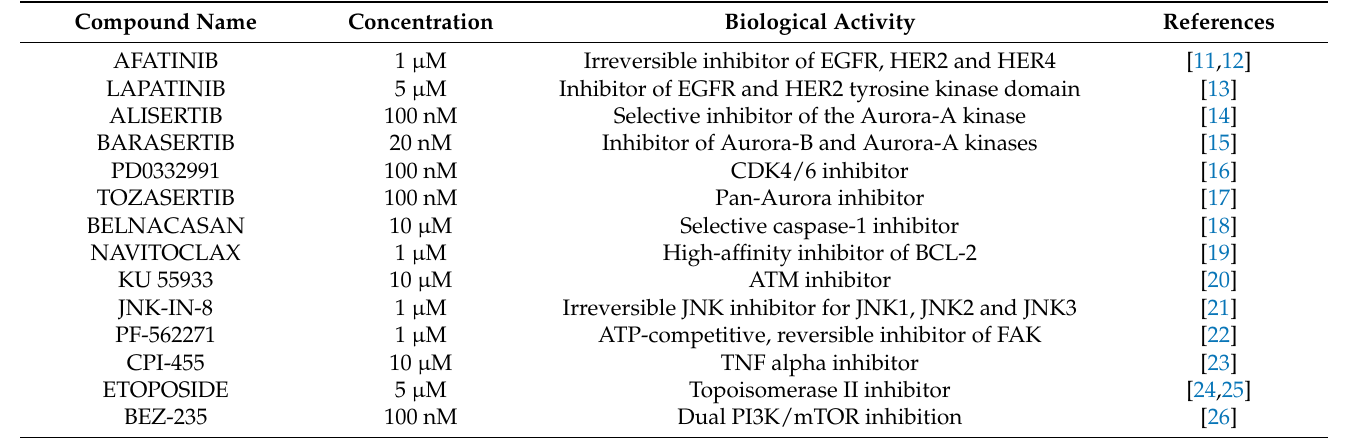
Table 1. Small molecule inhibitors used in the pan inhibitor